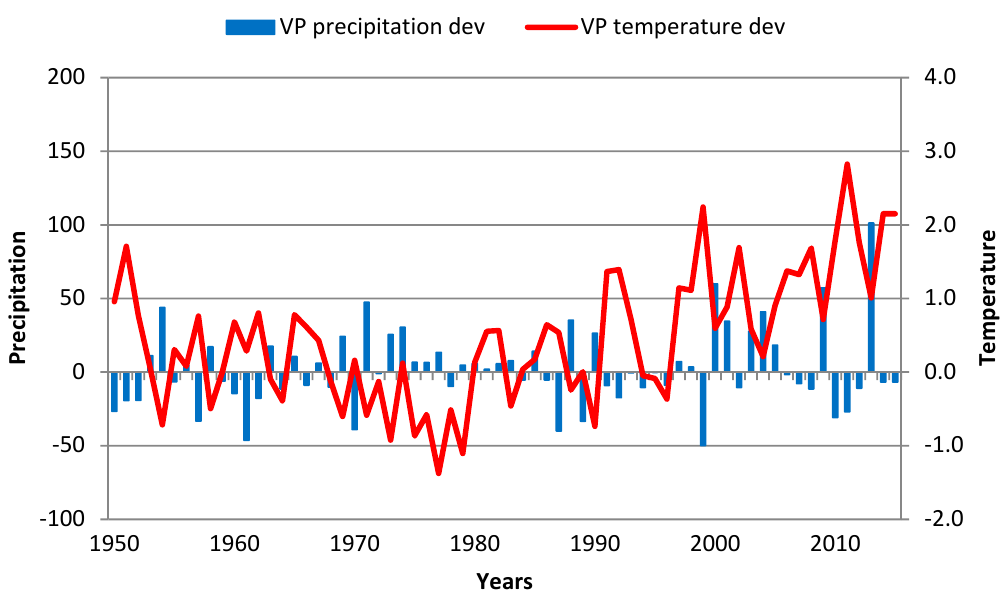
Figure 9. GS precipitation and temperature deviations in Lopare over the 1951–2013 period.Red line—GS temperature deviation; blue bar—GS precipitation deviation.